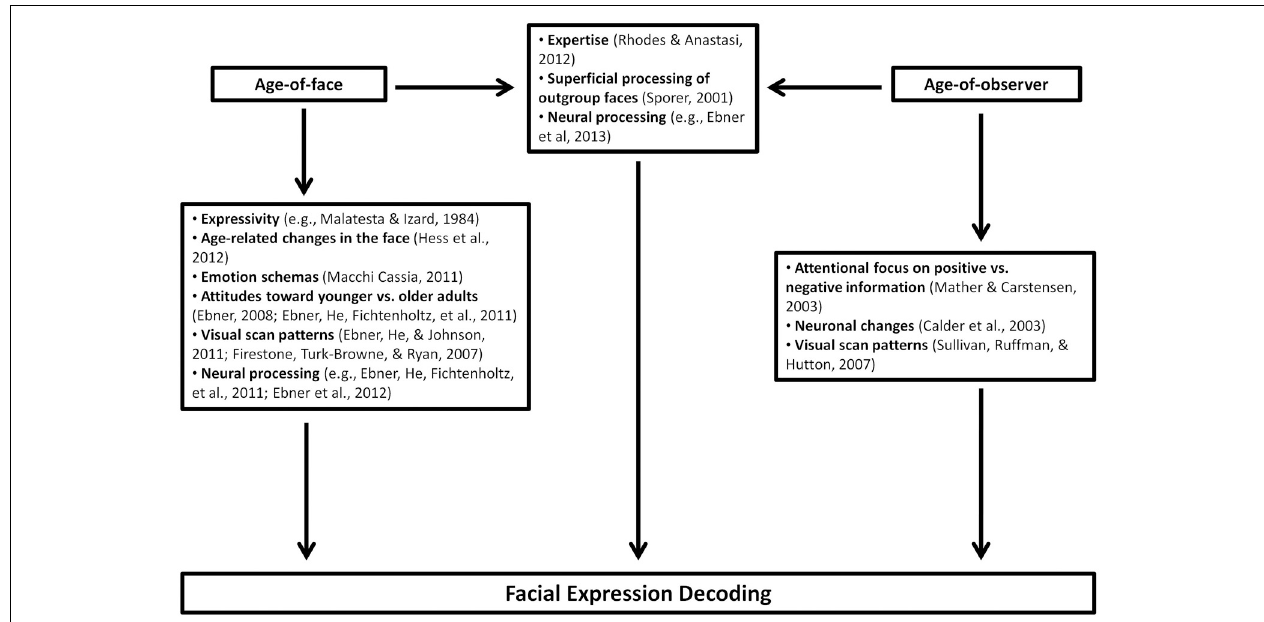
FIGURE 1 | Overview of mechanisms underlying effects of the age of the face (left part) and the age of the observer (right part) as well as own-age effects (central part) on facial expression decoding.